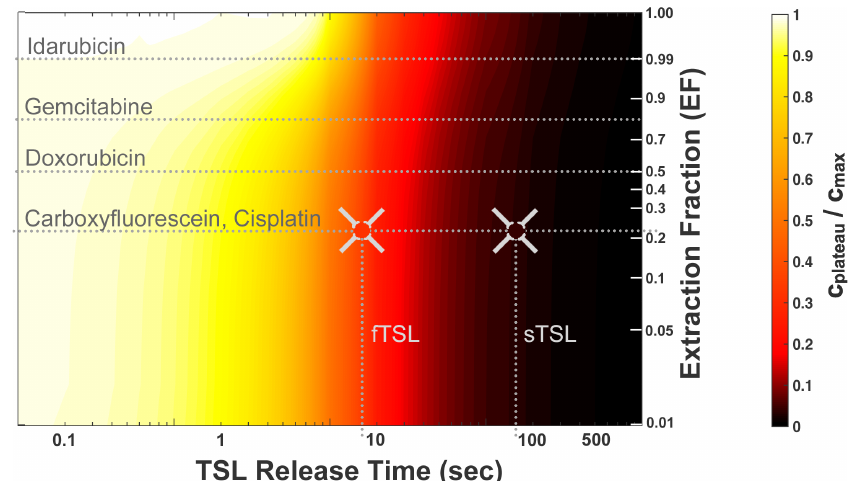
Figure 10. Drug extraction fraction (EF) and TSL release time dictate delivery efficacy. A parametric study was conducted based on an in vivo- validated computer model. The parametric study examined the interaction of two parameters that affect the maximum drug concentration achievable within the tissue interstitium (=plateau concentration (c plateau ); see Fig. 8): (1) TSL release time (see Fig. 7), and drug extraction fraction (EF). Delivery efficacy is indicated by the plateau concentration relative to maximum (c plateau /c max ), and is visualized by a color scale. The dotted horizontal lines indicate EF for four common chemotherapy agents, and for a common fluorescent drug analog (carboxyfluorescein). In a prior in vivo study, carboxyfluorescein was encapsulated in two TSL formulations: a fast-release (fTSL) and a slow-release formulation (sTSL) (compare Fig. 7). The two vertical dotted lines indicate the release times for fTSL (release time=8.2 s) and for sTSL (release time=63.0 s). The intersections of the horizontal dotted line corre- sponding to carboxyfluorescein and the vertical dotted lines indicate the location of experimental in vivo results for fTSL and sTSL in this map. The color inside the gray crosshairs corresponds to the measured in vivo plateau concentration. For highly permeable drugs (e.g. idarubicin, EF~1), a release time in the range of seconds is sufficient for near optimal delivery. For lower permeable drugs (e.g. cisplatin, EF~0.2), about 10x faster release (<0.1 s) is ideal. This study assumed a tumor transit time of 5.0 s based on in vivo measurements [20]. Figure reproduced from [20] (published under CC BY 4.0 license).